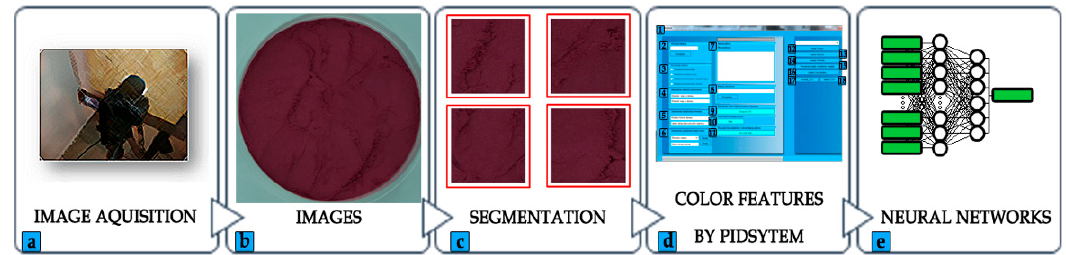
Figure 3. Scheme of color features which were extracted from the image to the learning process of Neural Networks: ( a )—taking pictures using the research stand; ( b )—creating of base of digital photos of chokeberry fruit powders; ( c )—image segmentation; ( d )—1—image processing module in “PID system”, 2—loading images in the “PID system”, 3—batch image processing selection, 4—determination of image coordinate values (x, y) to be cropped, 5—selection of image format, 6—selection of image pattern to change the name, 7—files list, 8—saving images to the destination directory, 9—extracting color characteristics from images (RGB, YCbCr), 10—approval of the processing process, 11—cleaning the list of objects from the file list window, 12—creating Laws masks, 13—creating Kirch masks, 14—creating Prewitt masks, 15—creating GLCM script to Matlab,